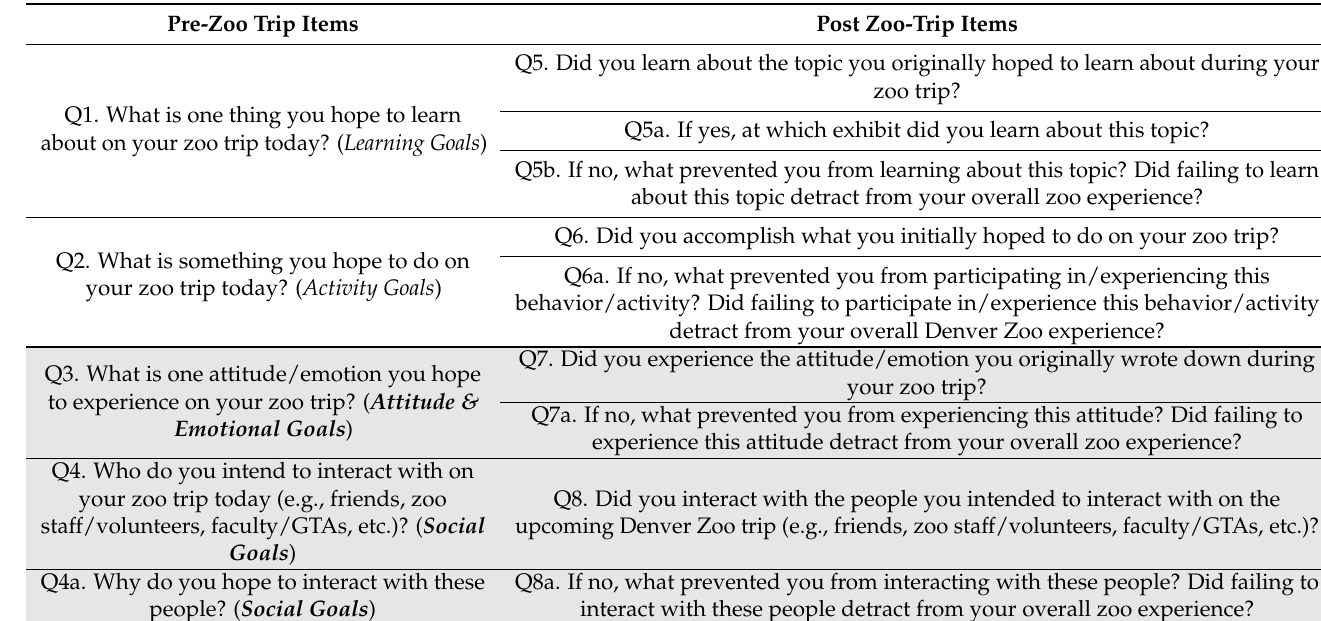
Table 1. Survey items. While students developed goals related to learning, activities, attitudes and emotions, and social groups, we report primarily on learning and activity goals (unshaded rows in table) in this manuscript. Pre- and post-survey questions are aligned in rows; for example, students answered Q1 at the start of the zoo trip and reflected on their Q1 response at the end of the zoo trip by answering Q5. Unshaded rows indicate our primary research questions, while shaded rows refer to our secondary research